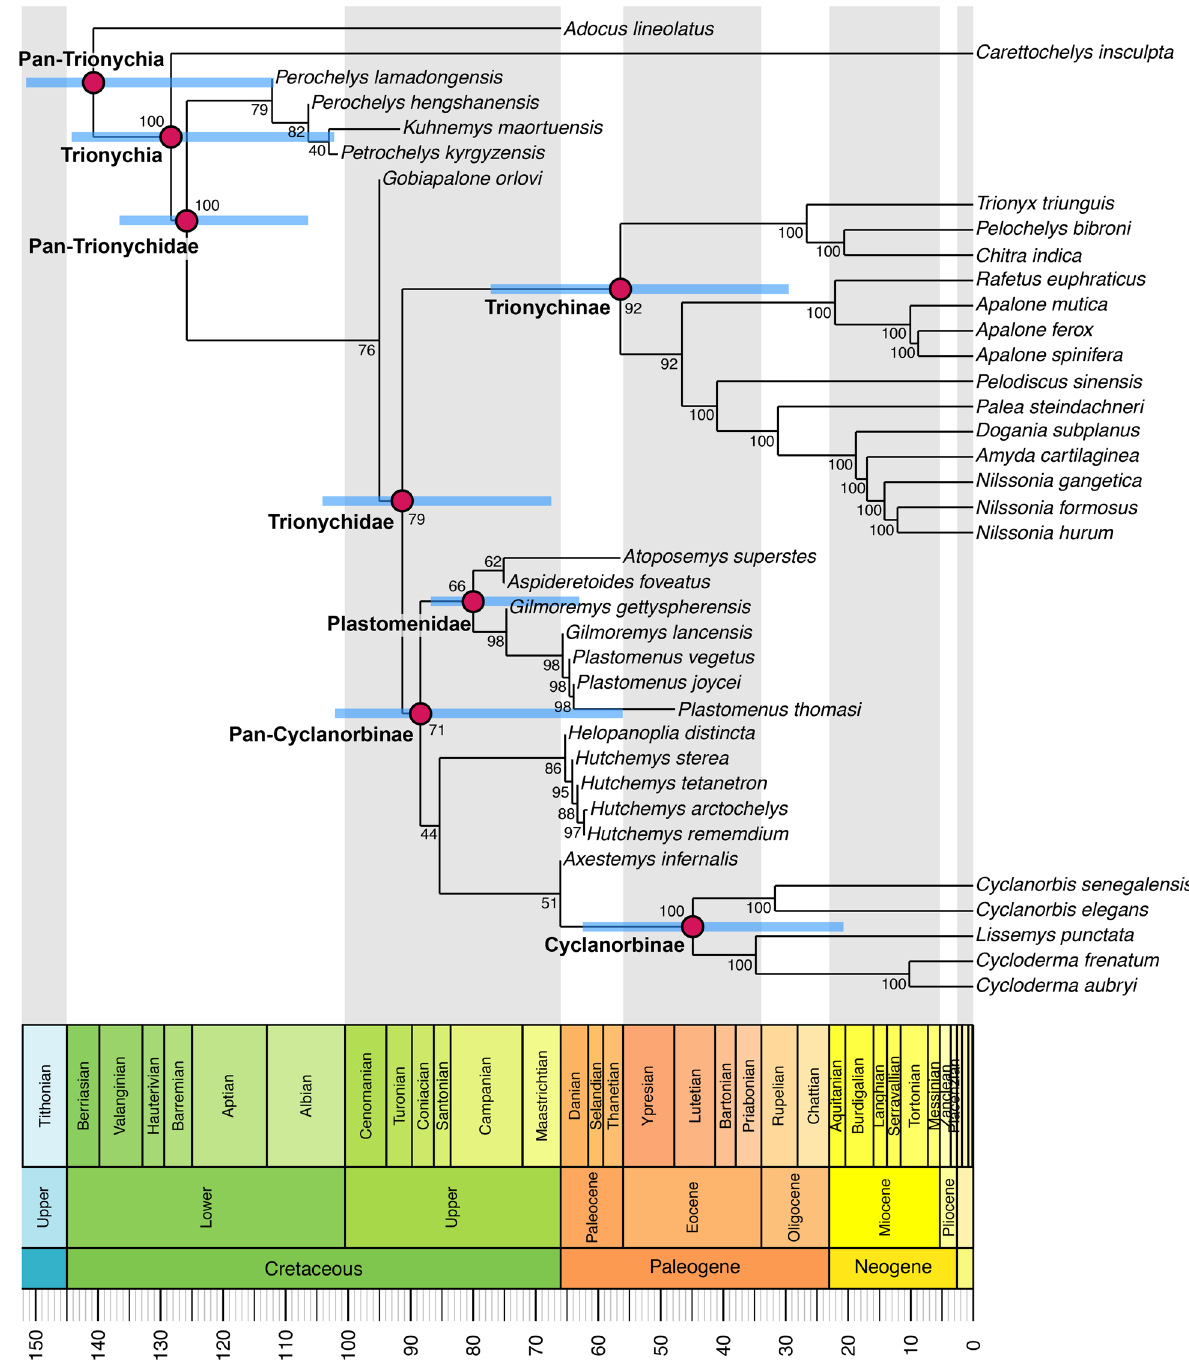
Fig. 14 Phylogenetic topology of the MCC tree retrieved from the Bayesian tip-dating analysis, scaled to geologic time. Major clades are labelled and shown with 95% HPD intervals for their estimated node ages. Small numbers at nodes are clade credibility